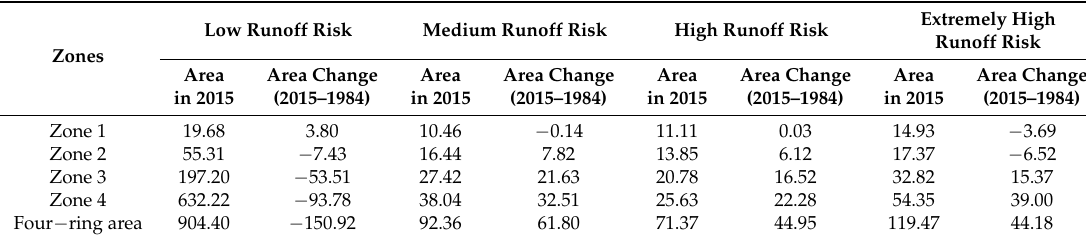
Table 5. Variation of regional runoff risk from 1984 to 2015 (km 2